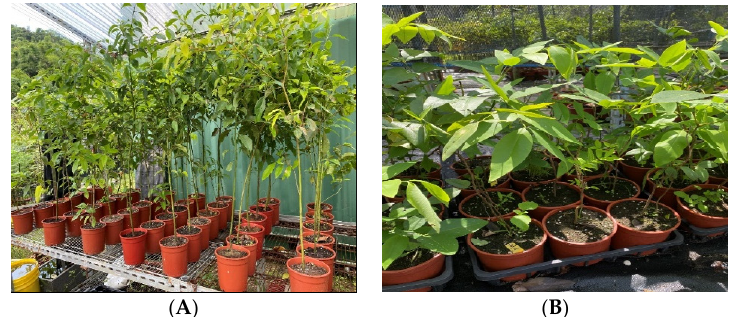
Figure 1. Saplings of camphor and golden shower trees in the 5” pot before the spray. ( A ) Camphor. ( B ) Golden shower.